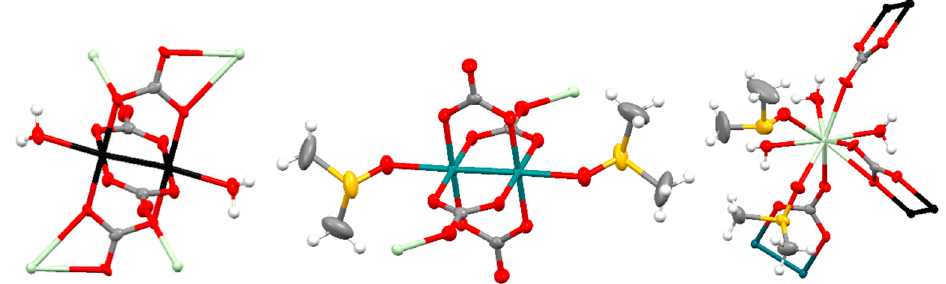
Figure 4. Representation (50% probability ellipsoids) of the coordination environments of the Ru 25+ ( left and center ) and Pr 3+ ( right ) units that form the structure of Pr α . Ruthenium: turquoise and black; praseodymium: pale green; oxygen: red; carbon: gray; sulfur: yellow; hydrogen: white. Ellipsoids of the hydrogen atoms are omitted for clarity.